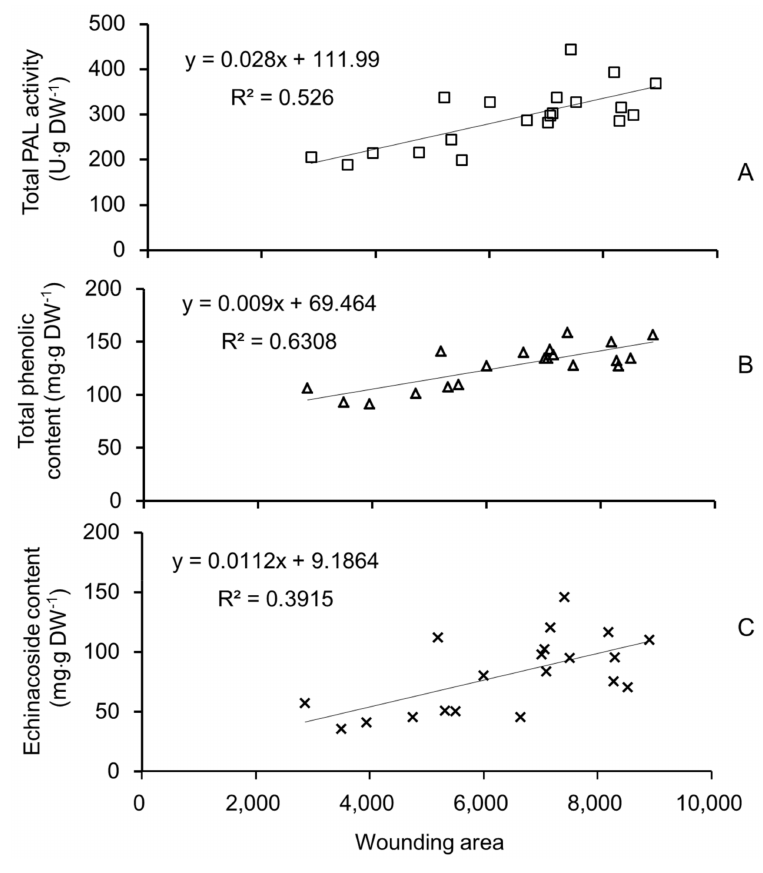
Figure 7. Linear regression analysis between wounding areas and PAL activity ( A ), total phenolic content ( B ), and echinacoside ( C